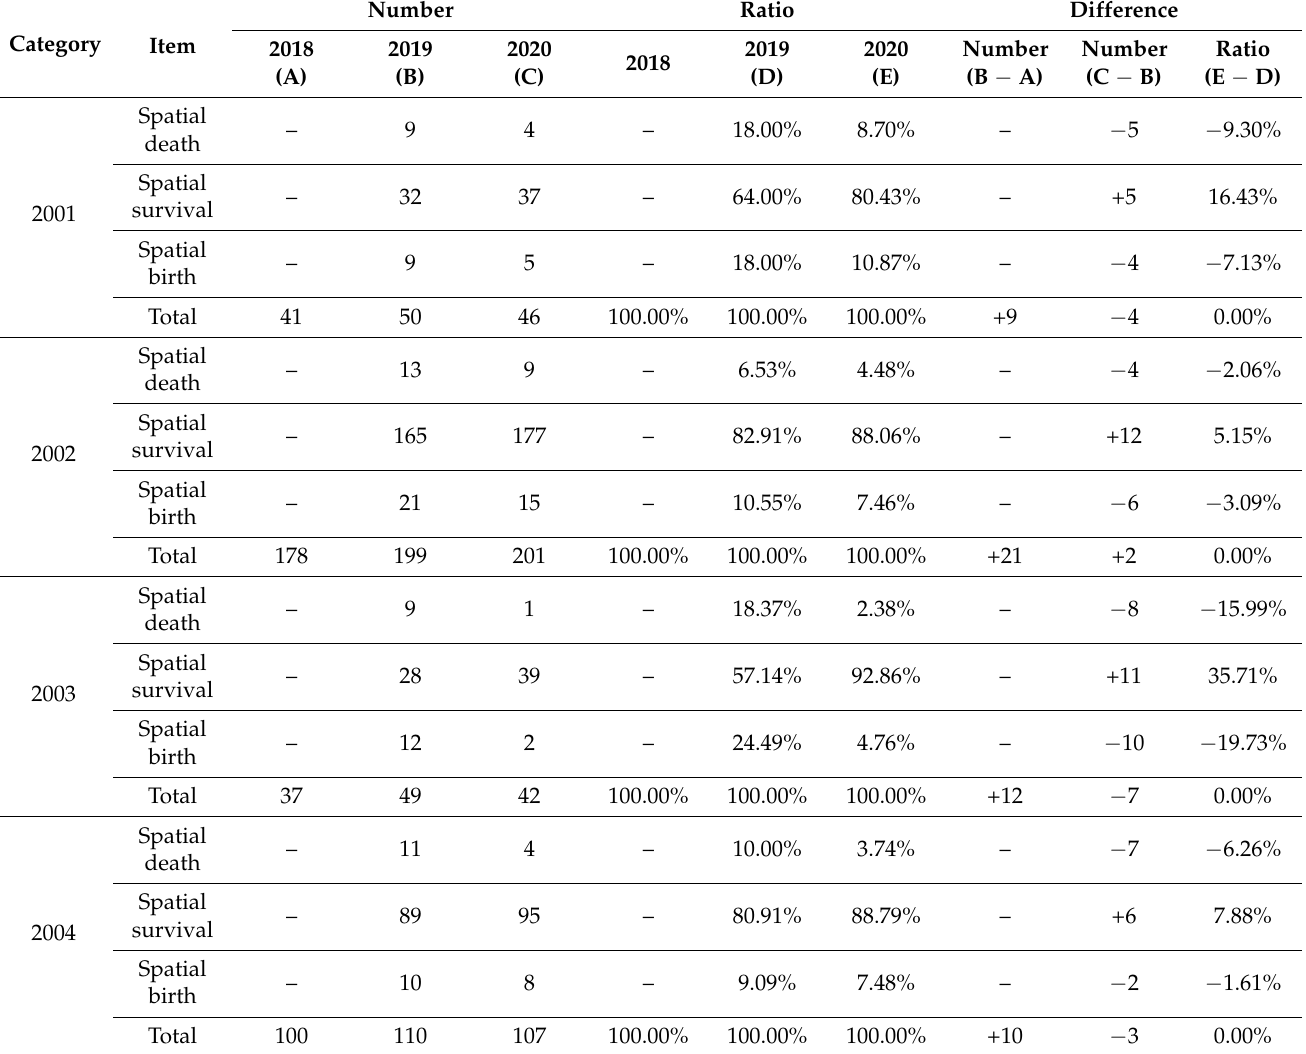
Figure 4. Distribution of industrial spatial concentration. Table 2. Statistics of spatial death, survival and birth of different categories.